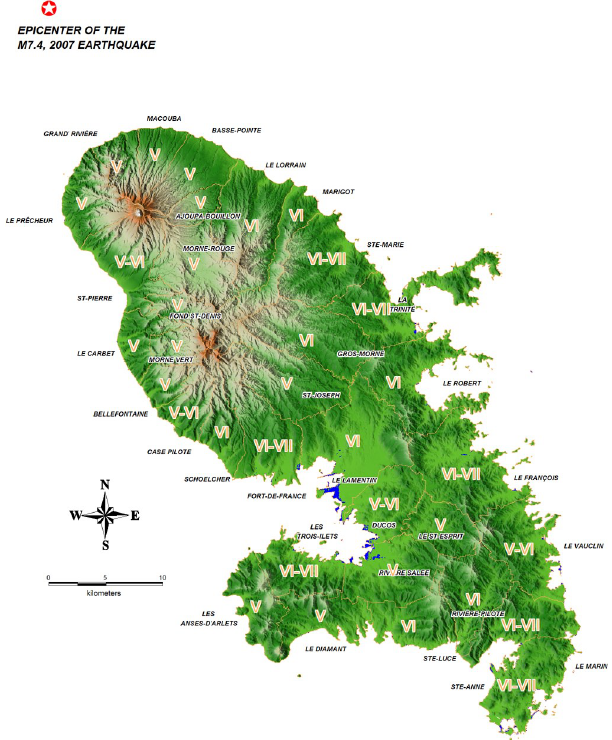
Fig. 2. The Martinique mountainous topography culminates at Mount Pel´ee volcano (1397m; 4583ft). The island is divided into 34 municipalities; Roman letters plotted into municipality areas rep- resent the EMS98 intensities evaluated after the M = 7.4, Novem- ber 2007 slab earthquake (data from BCSF,